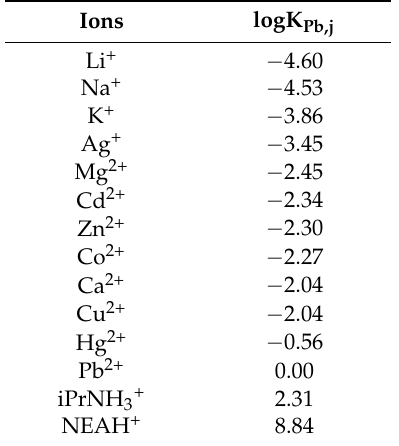
Table 1. Potentiometric selectivity of the polyvinyl chloride (PVC)-based electrode membrane containing ligand rac - 4 and o-NPOE as the plasticizer for different metal ions and protonated primary amines.